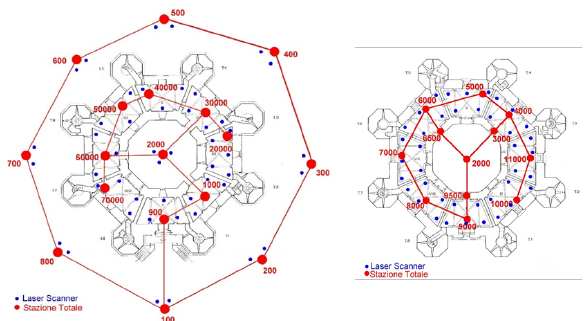
Figure 5. Export data in .dxf